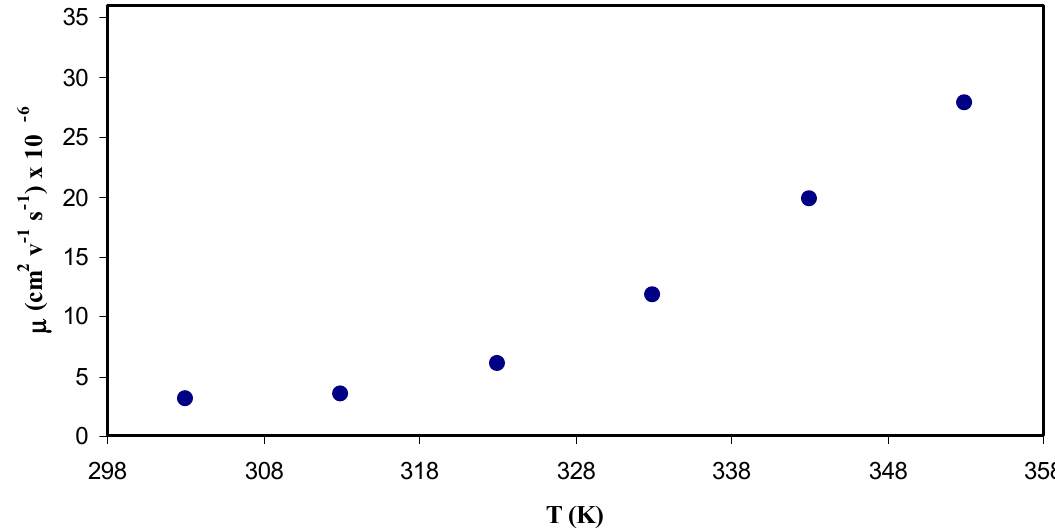
Figure 14. Carrier number density as a function of temperature. It is clear that the number density of ions slightly increases with increasing temperature.